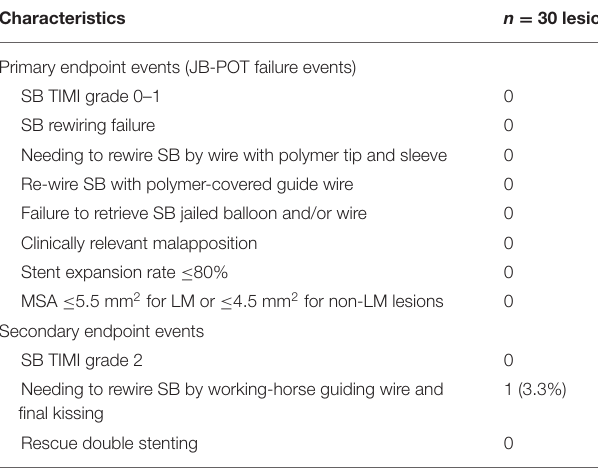
TABLE 1 | Patient characteristics.